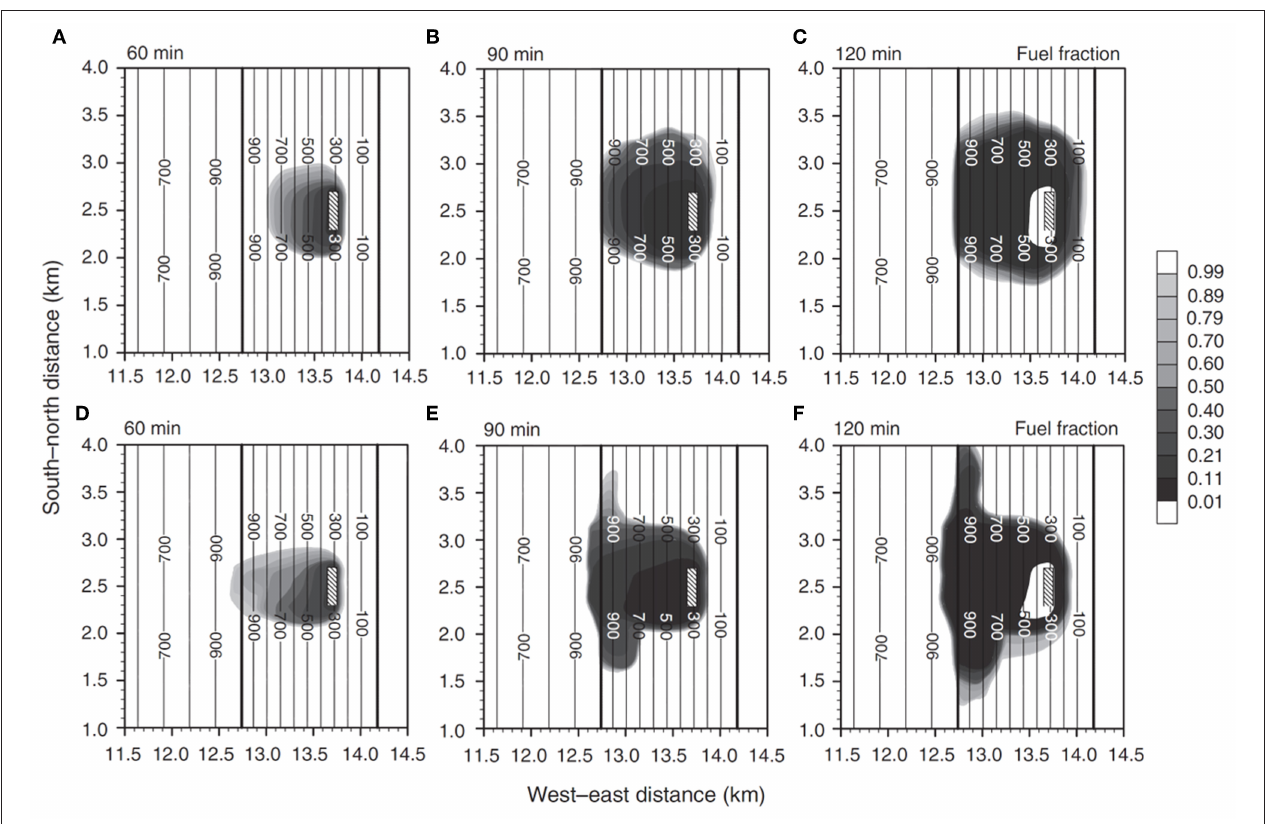
FIGURE 7 | Coupled fire-atmosphere model output of a fire burning on a leeward slope at times of 60, 90, and 120 min into the simulation. Panels (A–C) show model output when the fire-atmosphere coupling is turned off, while panels (D–F) show model output when the fire-atmosphere coupling is turned on. The gray shading indicates the instantaneous fuel fraction remaining. White shading is applied to regions where the fuel fraction remaining is over 99% or under 1%. Terrain contour lines are given at 100-m intervals and the solid black lines represent the ridge line of the hill and the base of the leeward slope. The fire ignition region is indicated by the dash-filled region. The figure has been adapted from Simpson et al.